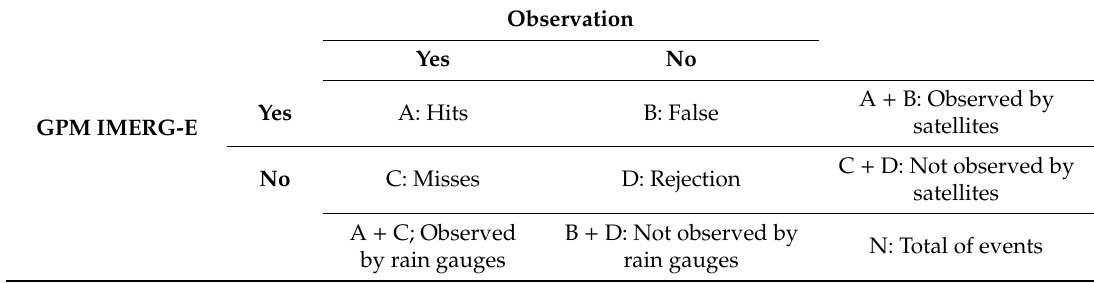
precipitation. POD: probability of detection, FAR: false alarm